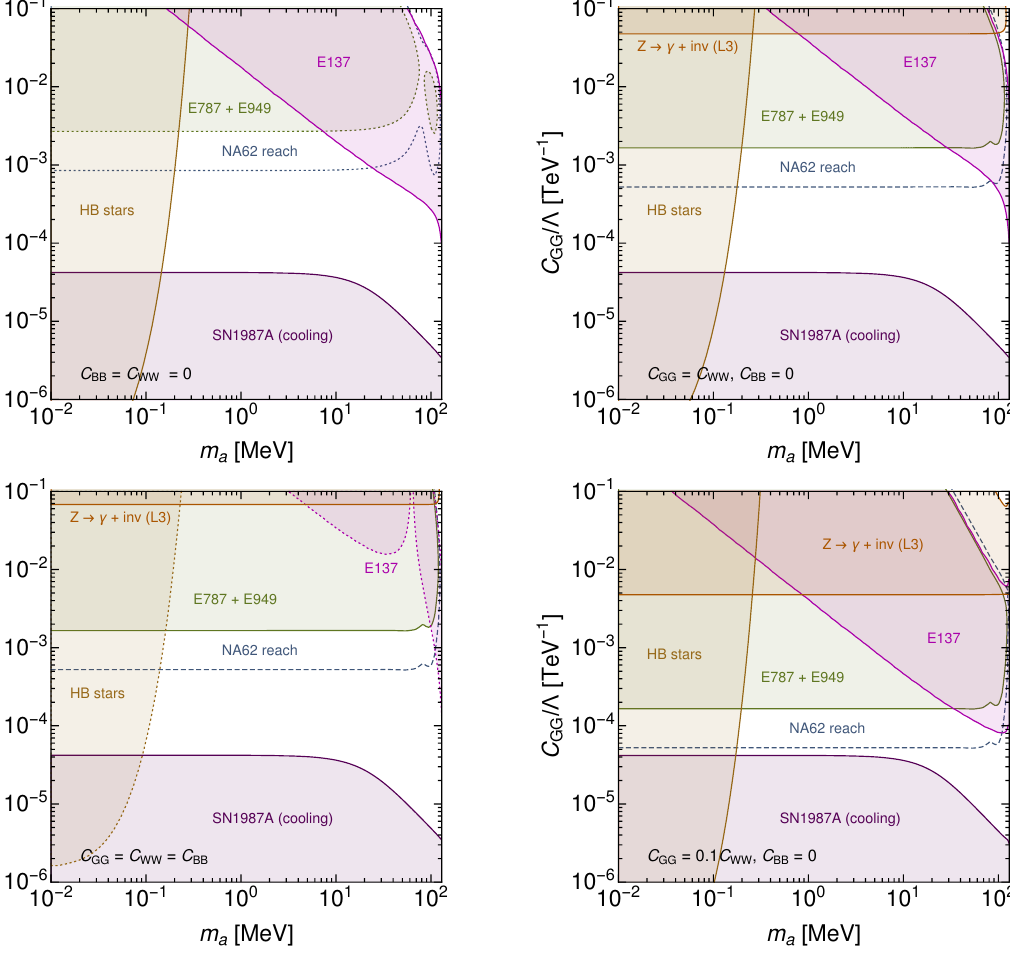
Figure 4 . Experimental constraints and prospects on ALPs interacting with SM gauge boson for m a < m (cid:25) for di(cid:11)erent ALP couplings. Starting from the top left (clockwise) we focus on dominant C GG , then C GG = C WW followed by C GG = 0 : 1 C WW and lastly C GG = C WW = C BB . Constraints that are a(cid:11)ected by hadronic uncertainties (most importantly the ALP mixing with (cid:17) and (cid:17) 0 ) are shown with dotted